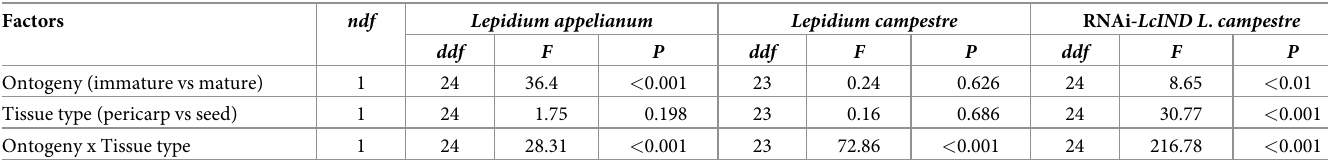
Table 1. Two factorial general linear model analysis of variance on the effects of ontogeny (mature and immature) and tissue type (pericarp and seed) on total glu- cosinolate concentrations in Lepidium appelianum (n = 7), L . campestre (n = 7) and transgenic RNAi- LcIND L . campestre (n = 7). Factors Ontogeny (immature vs